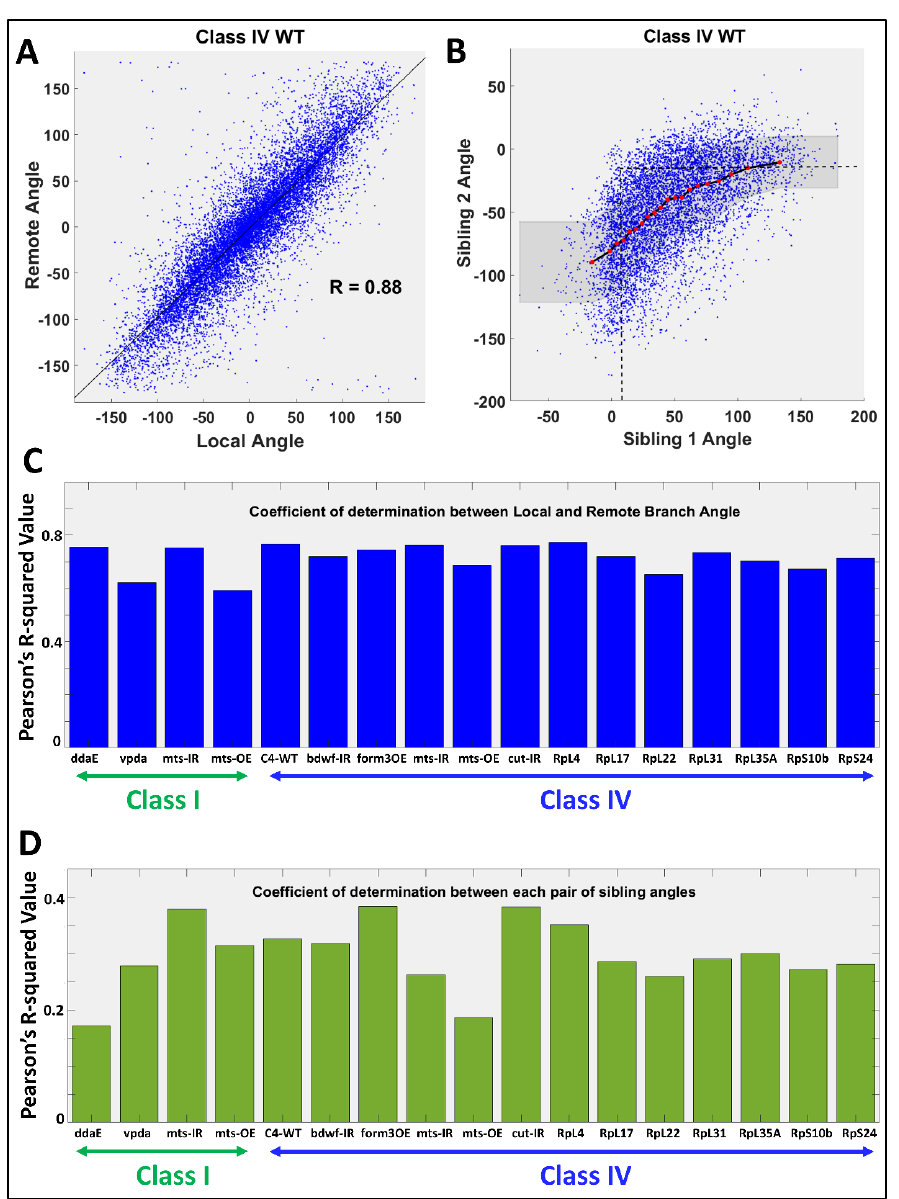
Figure 3. Analysis of Branch Angular Deviation. ( A ) Scatter plot of remote vs. local branch angles reveals strong positive correlation in Class IV WT neurons. ( B ) The signed angular deviations of sibling branches (also in Class IV WT neurons) are positively correlated and they usually deviate in opposite directions. This corresponds to a negative correlation between the absolute angular deviations (see Supplementary Materials Table S2). ( C ) Coefficients of determination between local and remote branch angles across the 17 neuron groups. ( D ) Coefficients of determination of the signed remote angle between each pair of sibling branches across the 17 neuron groups.